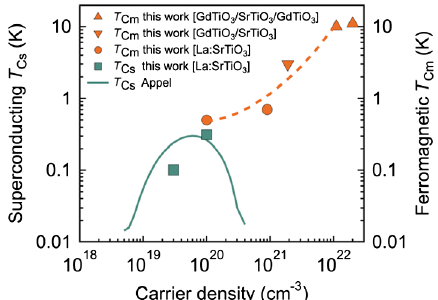
FIG. 5. Superconducting and ferromagnetic transition tem- peratures of SrTiO 3 as a function of carrier concentration. Literature data for the superconducting transition temperatures are from Appel et al. [33]. The sheet carrier densities of the quantum wells ( n 2D ) were converted to 3D carrier concentrations ( n 3D ) according to n 3D ¼ n 2D =t cm (cid:1) 3 , where t is the thickness of the quantum well and n 2D is the carrier concentration deter- mined from the Hall measurements at 5